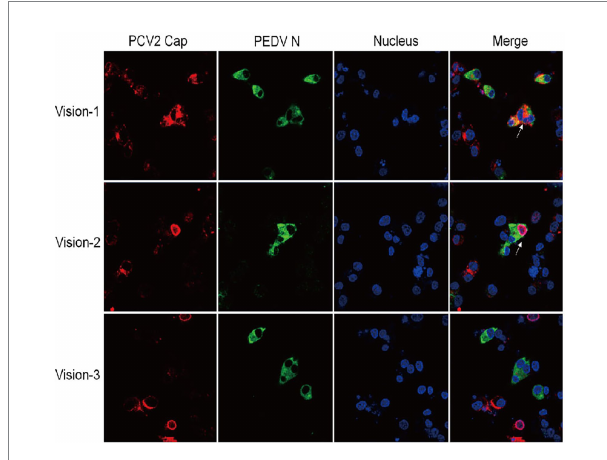
FIGURE 3 IPI-FX cells support the replication of both PEDV and PCV2 together. IPI-FX cells were inoculated with both PEDV and PCV2d-LNHC. At 72 h after inoculation, the cells were fixed, stained with an immunofluorescence assay (IFA), and observed with laser confocal microscopy. White arrows indicate cells infected with PEDV and